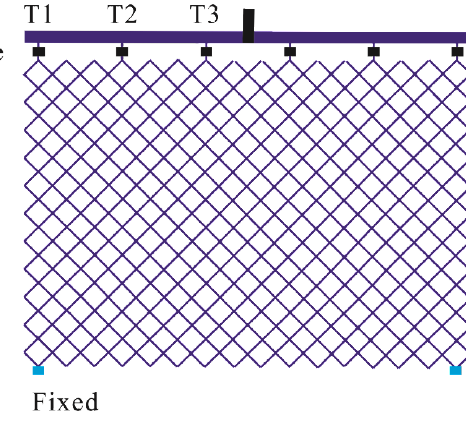
Figure 6. Setup of net panel and eight-point mooring system.